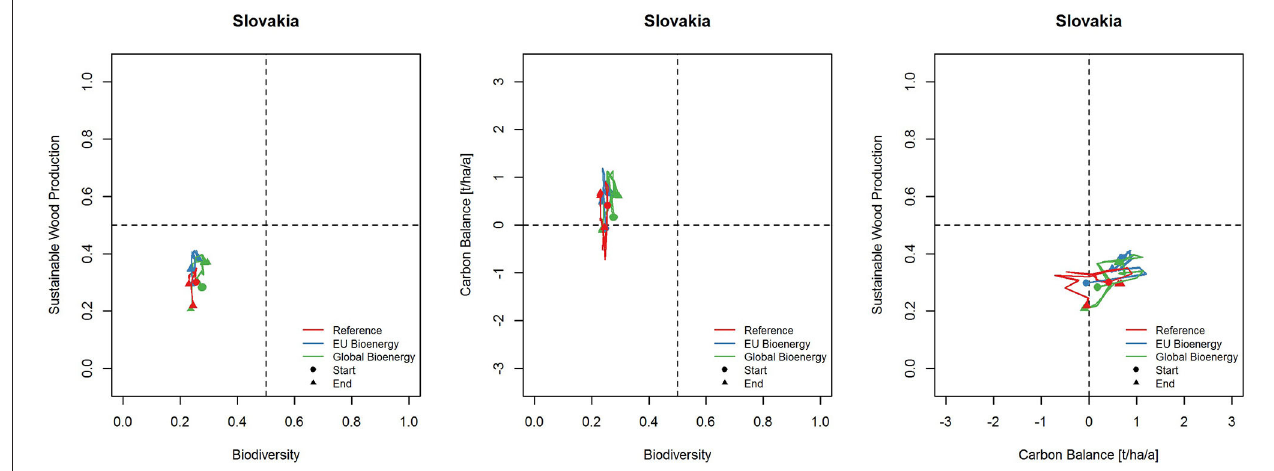
FIGURE 7 | Trade-off diagrams for Slovakia.